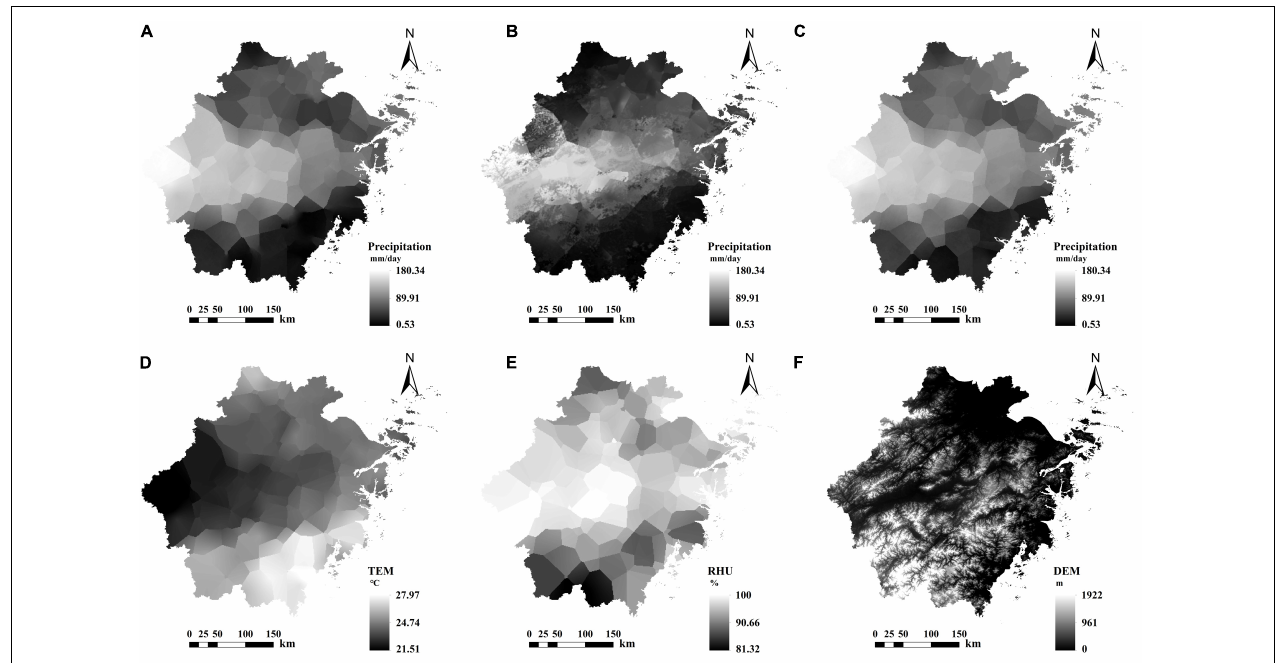
FIGURE 9 | The spatial patterns of the BPNN-based product (A) , SVM-based product (B) , MLR-based product (C) , TEM (D) , RHU (E) , and DEM (F) in event